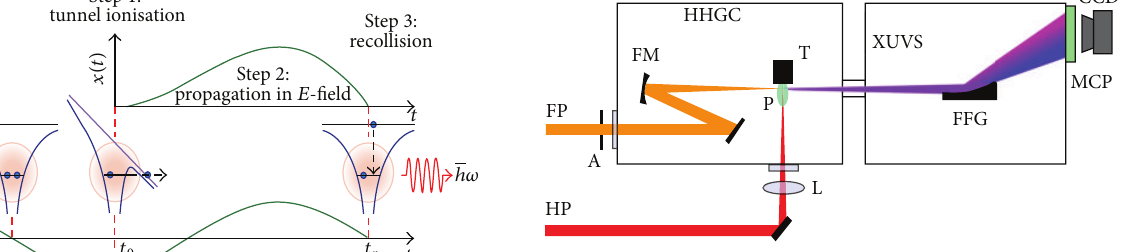
Figure 2: Experimental setup for harmonic generation in plasma plumes.FP:femtosecondprobepulse,HP:picosecondheatingpulse, A: aperture, HHGC: high-order harmonic generation chamber, FM: focusing mirror, L: focusing lens, T: target, P: plasma, XUVS: extreme ultraviolet spectrometer, FFG: flat field grating, MCP: microchannel plate and phosphor screen detector, CCD: CCD camera